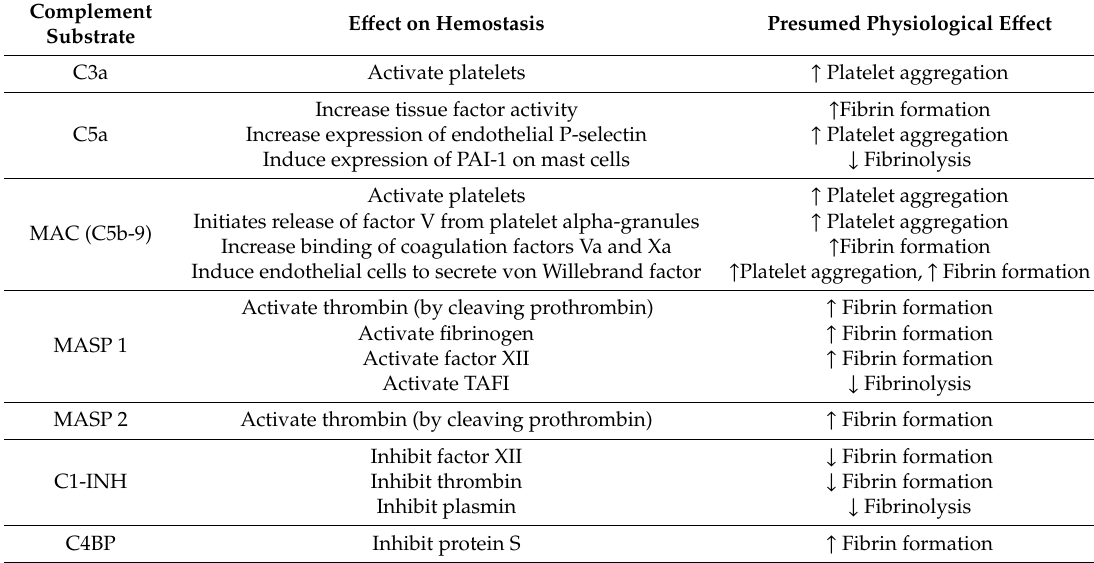
Figure 2. A schematic overview of complement-mediated coagulopathy. Table 1. Complement-mediated coagulopathy: molecular